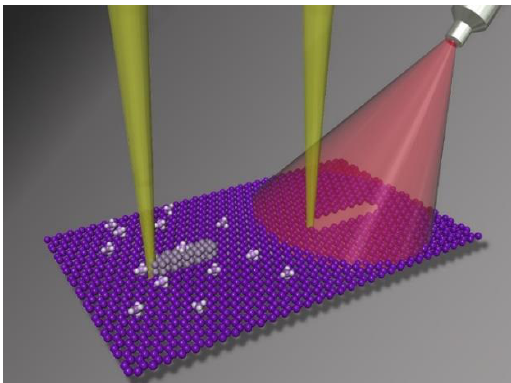
Figure 1. Schematic of He + beam exposure on a single layer graphene sample. Carbon contamination introduced during transfer process impedes a clean cut by the He + beam, and results in carbon deposition due to the cracking of residual hydrocarbon species. The carbon contamination can be reduced with the assist of an in situ pulsed laser, and thus ion milling is possible with appropriate laser conditions.